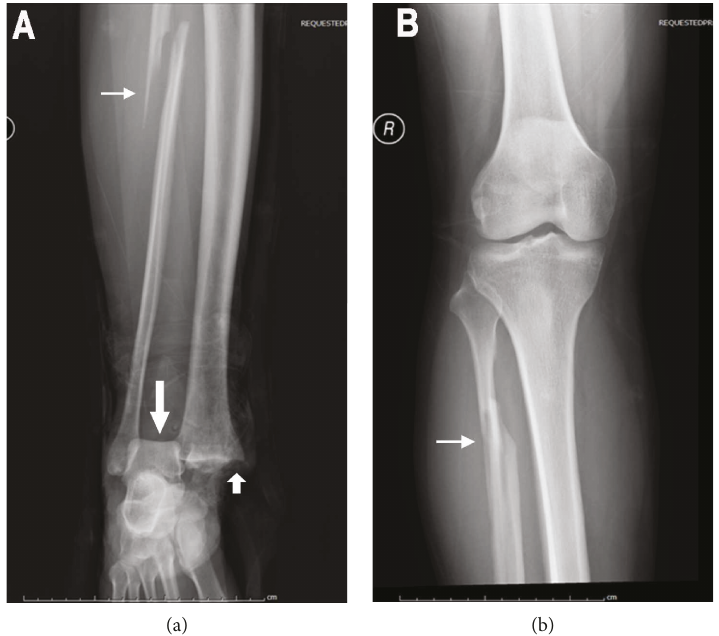
Figure 3: Anteroposterior radiographs of the right shin and foot and the knee joint. (a) Anteroposterior radiograph of the right shin and foot. Talus “ wedged ” into the ankle syndesmosis (long thick white arrow), fracture of the medial malleolus (short thick white arrow), and proximal fi bular fracture (thin white arrow) are seen. (b) Anteroposterior radiograph of the right knee joint. Proximal fi bular fracture is indicated with a thin white arrow.